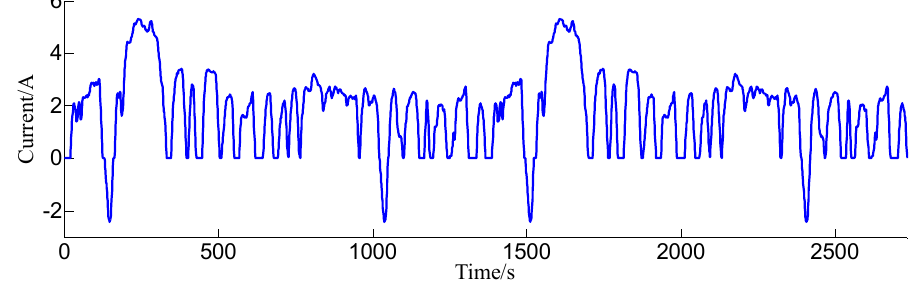
Figure 11. The input current waveform.